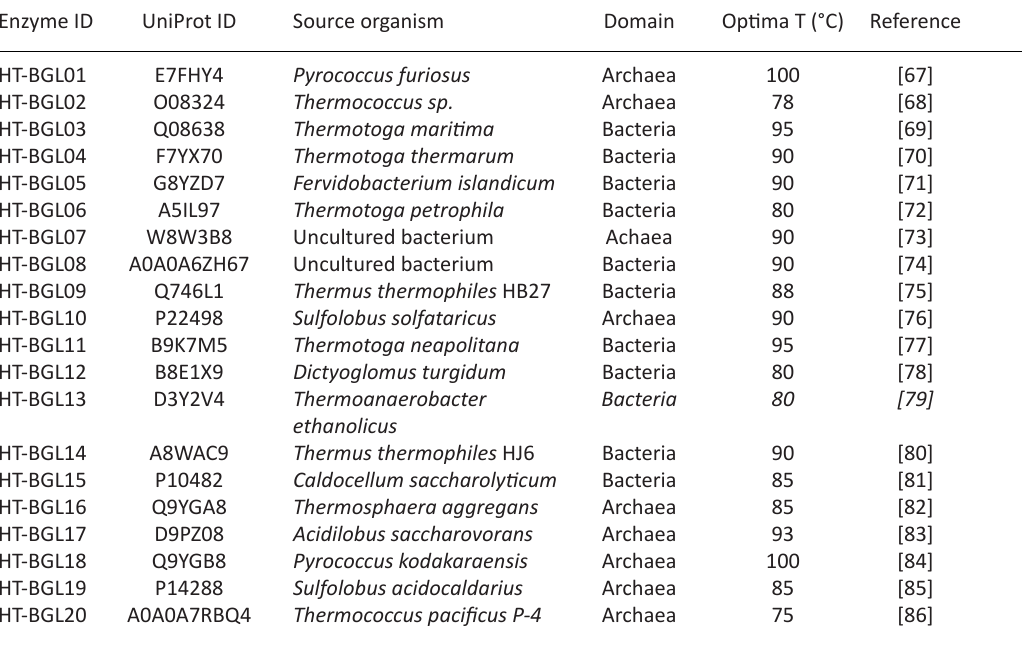
Table 3. Hyperthermophilic GH1 β -Glucosidase with UniProt ID and reported optimal temperature Enzyme ID UniProt ID Source organism Domain Optima T